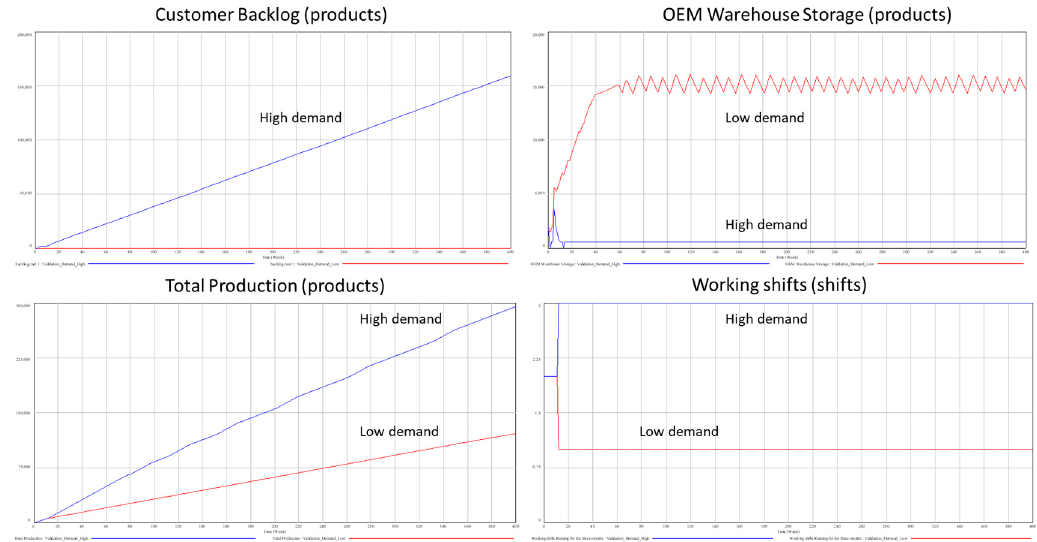
Figure 5. Generated demand scenarios based on lifecycle demand patterns (own elaboration).